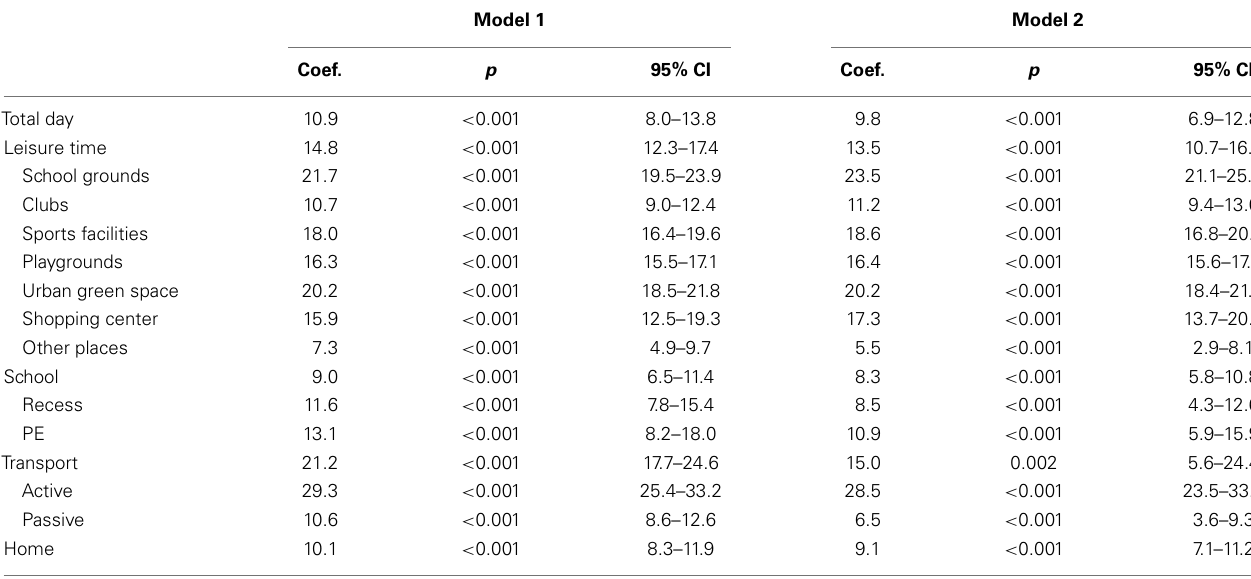
Table 7 |Association between time outdoors (hours) and MVPA (minutes) in total weekdays, domains, and subdomains. Model